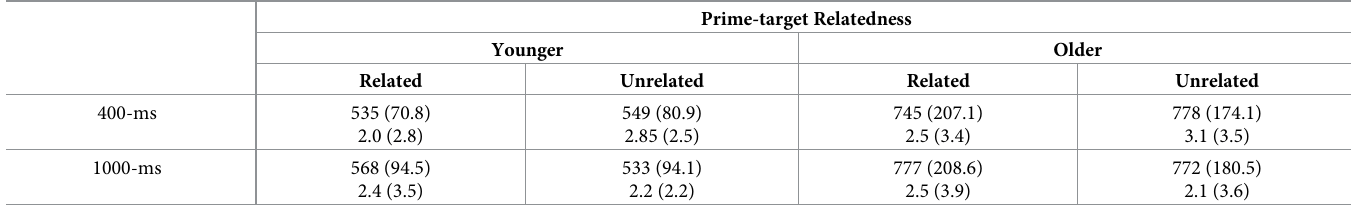
Table 5. Results of the Congruency-Priming task for both age